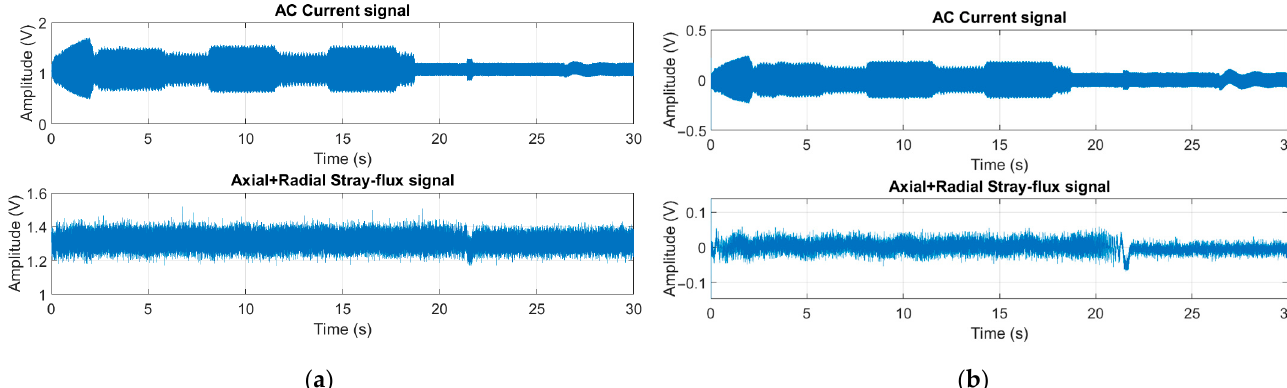
Figure 10. Current and stray flux signals measured during the 100 m/rev test with the CT-s5 tool: ( a ) original signals; ( b ) conditioned signals.